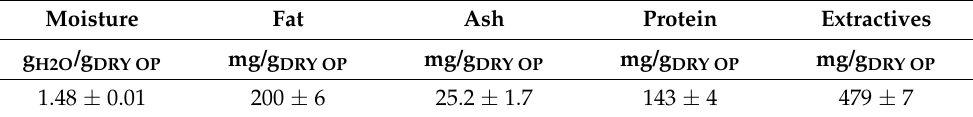
Table 6. Olive pomace (OP) characterization.